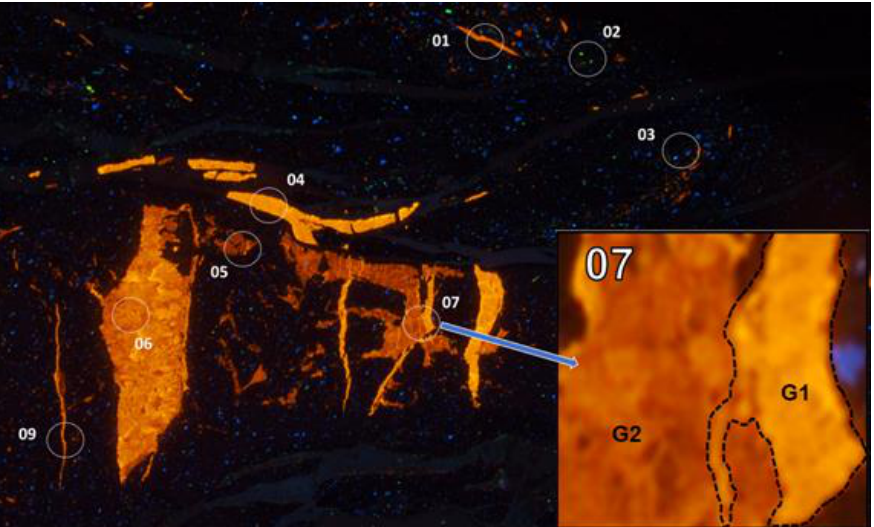
Figure 4. CL image containing two visually distinct generations of calcite vein growth and predefined regions of interest for spectral sampling and vector data creation. Because of significant spectral variation and superimposition among growth features, we infer that there are two distinct generations of calcite and that generation 1 (G1) is relatively younger than G2.2.4.2. CL Image